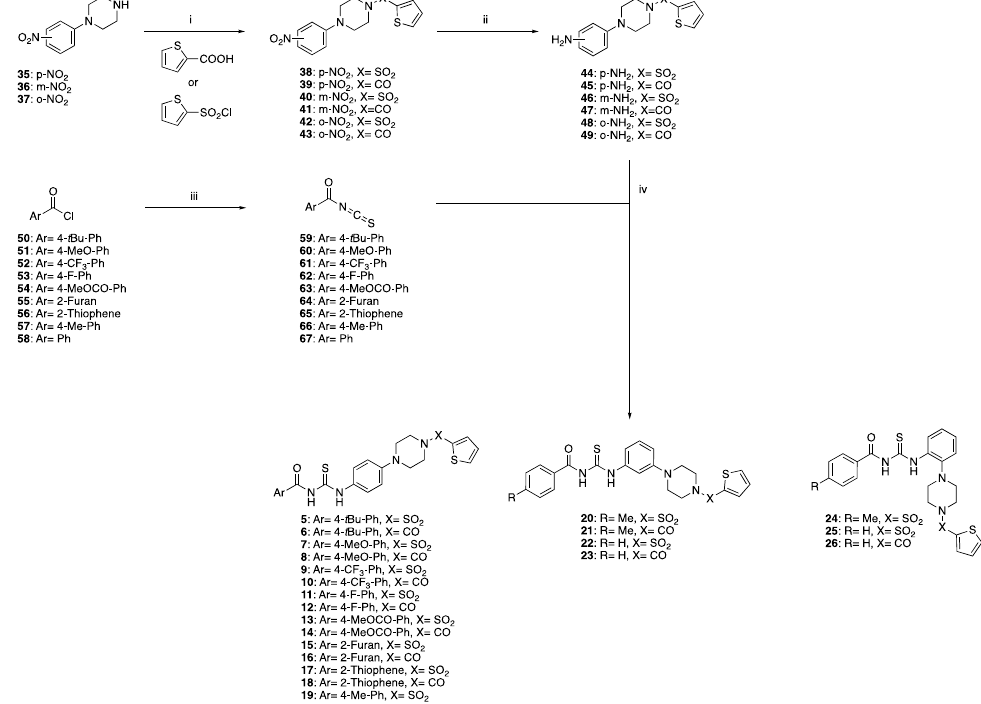
Scheme 1. Synthesis of target compounds 5–26. Reagents and conditions: (i) TBTU, DiPEA, DMF, r.t., 5 h, OR Et 3 N, DCM,